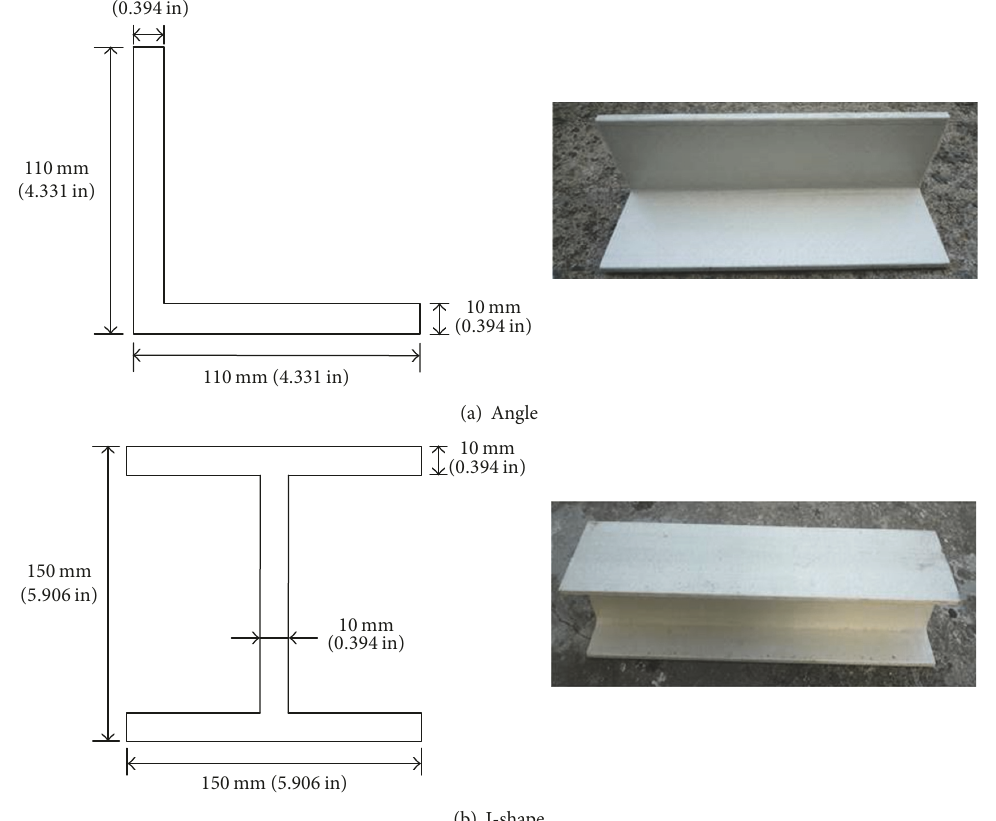
Figure 2: Structural shape and its cross-section dimension.